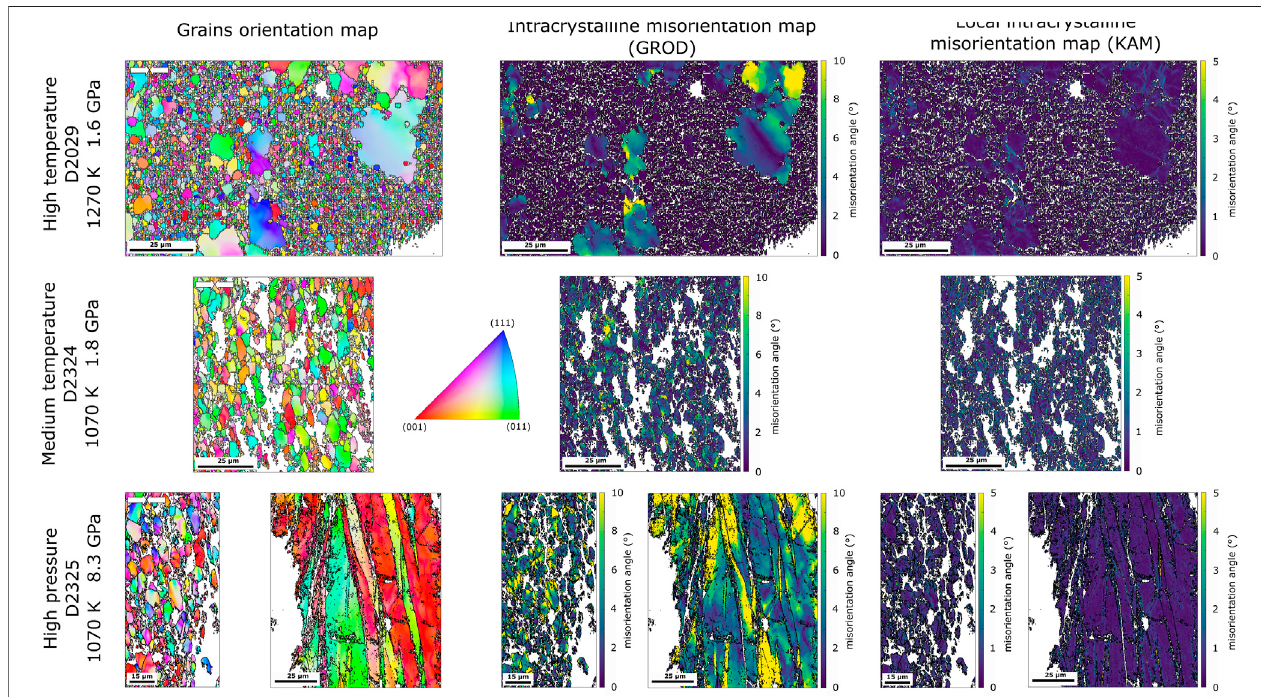
FIGURE 8 | EBSD samples features. Representative orientation maps (A,D,G,H) , intracrystalline misorientation (B,E,I,J) , and local misorientation gradient (C, F,K,L) for samples D2029 (A,B,C) , D2324 (D – F) , and D2325 (G – L) . Orientation maps are colored according to grain orientation relative to the compression direction (inset). Intracrystalline misorientation is represented by GROD maps showing the internal deformation in each grain relative to the mean orientation of the grain. Local misorientation gradient maps are KAM maps showing the internal deformation gradient in each grain. High resolution maps of these fi gures are available in the Supplementary Materials ( Supplementary Figures S2 – S10